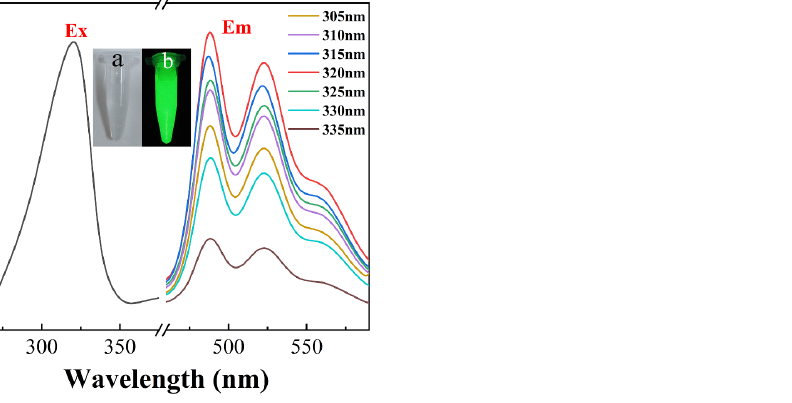
Figure 3. Fluorescent excitation ( left ) and emission ( right ) spectra of Ag-TPA CPNs. The inset picture shows the photos of the fluorescent Ag-TPA CPN solution under visible light ( a ) and a 302 nm UV lamp ( b ). Ag-TPA CPN solution: 50 μ L.